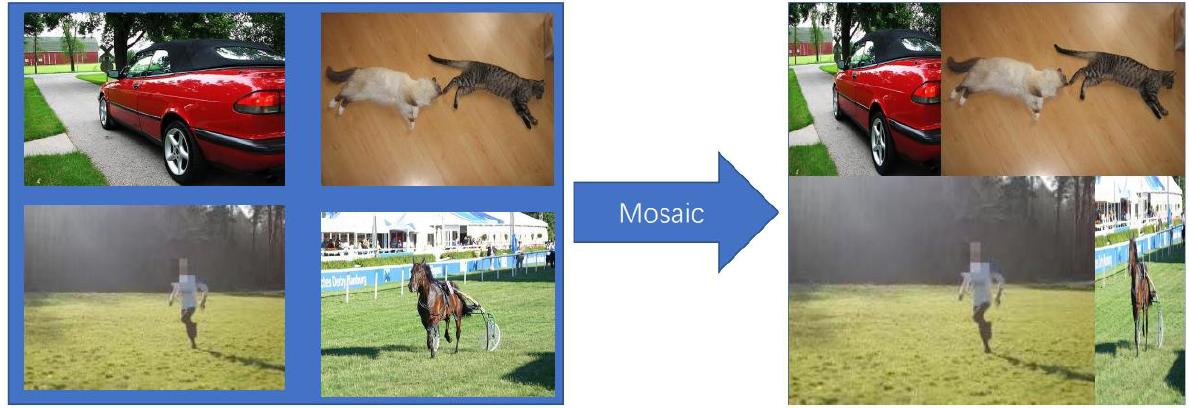
Figure 2. Mosaic data augmentation.